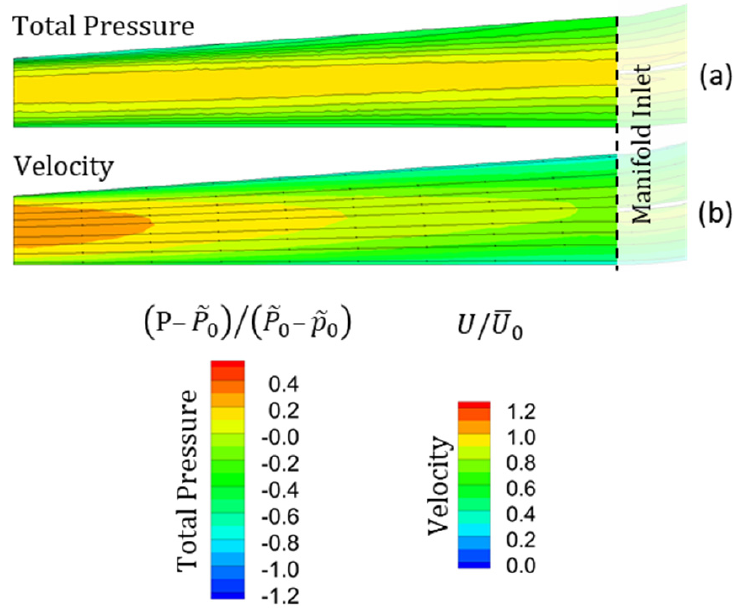
Figure 25. Diffuser 2 CFD prediction—Contours of normalised total pressure ( a ) and normalised velocity magnitude ( b ).